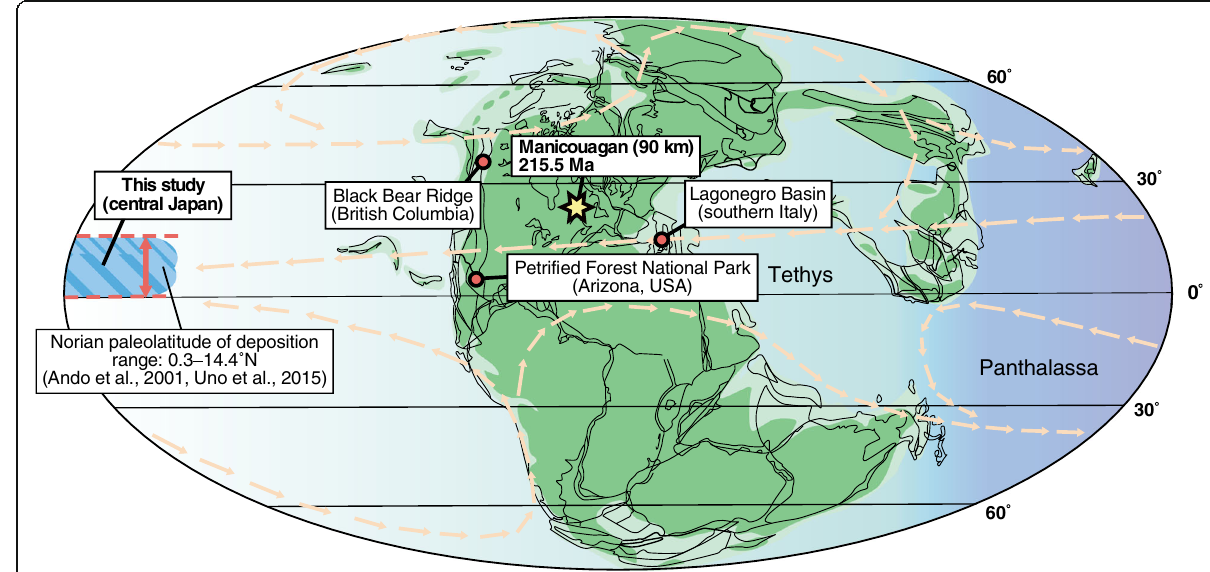
Fig. 2 The paleogeography in the Late Triassic. Approximate location of the Manicouagan crater and the inferred depositional area of the bedded chert in the Mino Belt in low-latitude zones of the Panthalassa Ocean (Uno et al. 2015). The red circles represent the approximate paleo-locations of the Late Triassic sites. The orange arrows are the simulated surface winds from Kutzbach and Gallimore